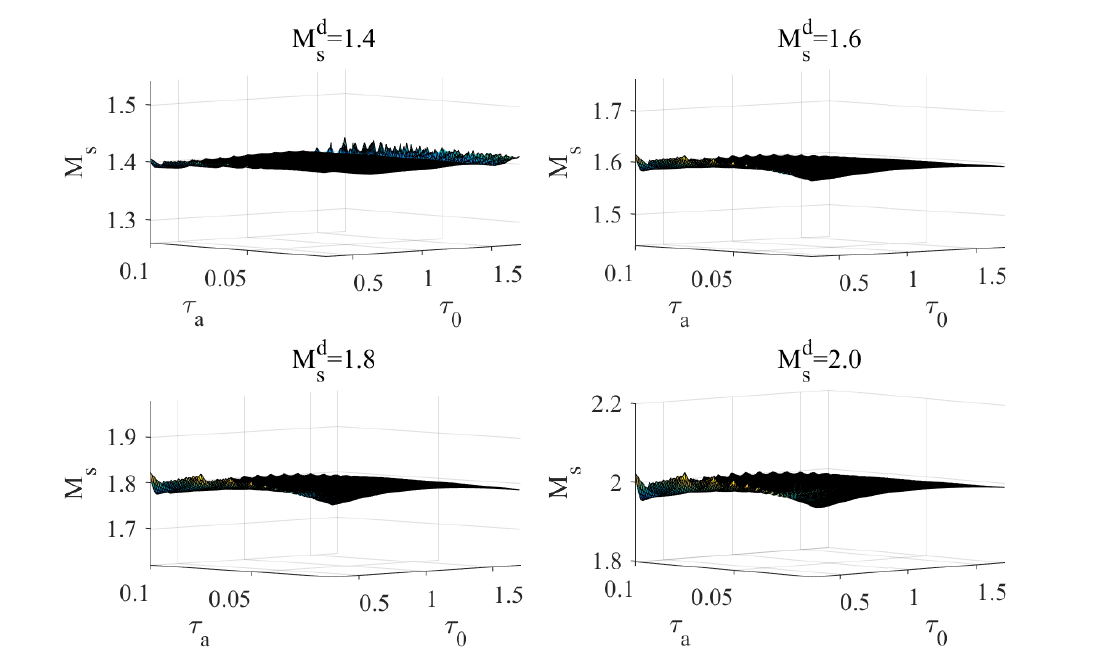
Figure 5. Relationships among the obtained M s , τ 0 , and τ a in regulation